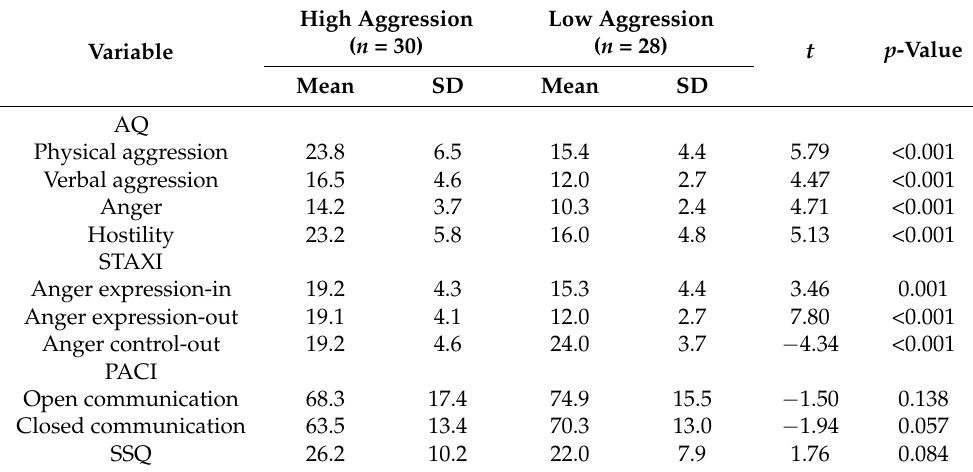
Table 1. Mean and standard deviation (SD) of psychological scale scores in participants with high aggression and low aggression.